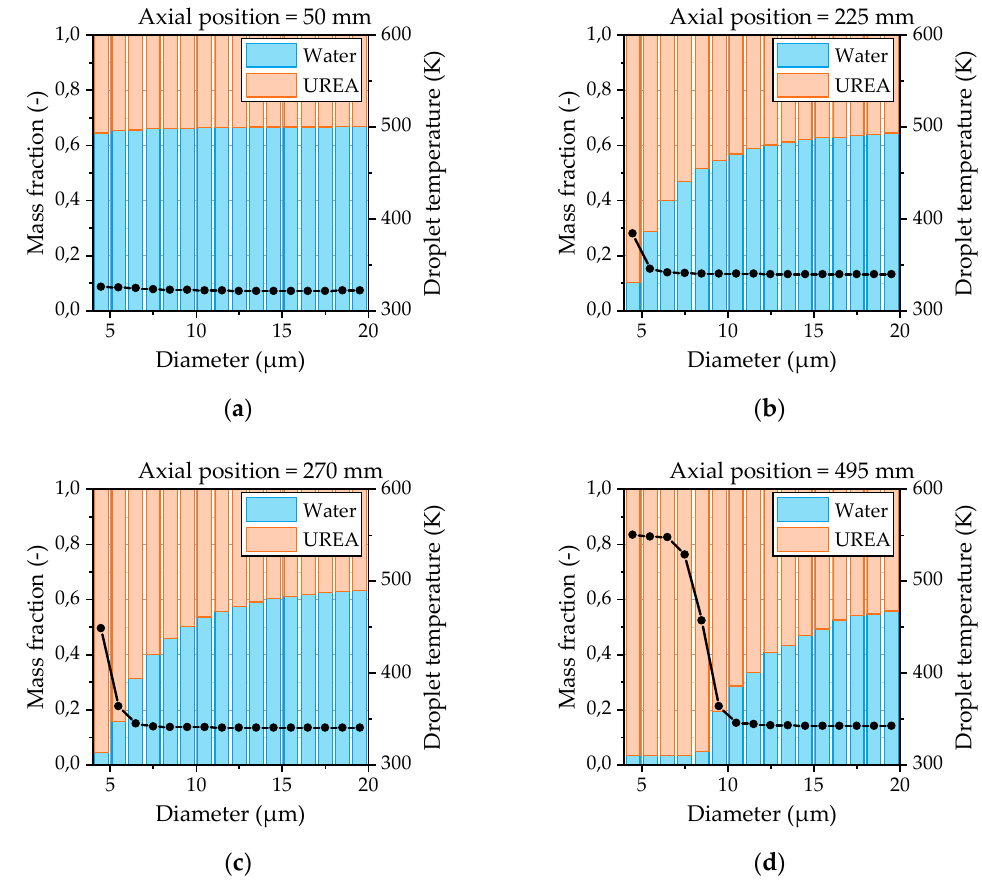
Figure 16. Droplet composition depicted by the mass fractions of urea and water as a function of the droplet size with the corresponding droplet temperature in an axial distance of 50 mm ( a ), 225 mm ( b ), 270 mm ( c ) and 495 mm ( d ) downstream of the nozzle.